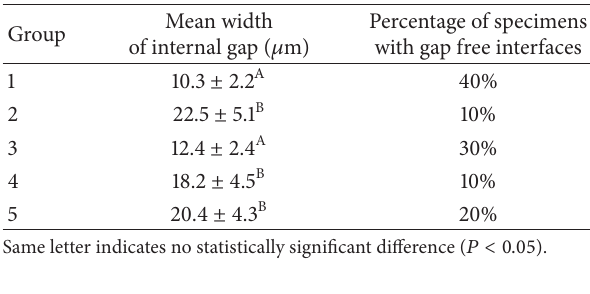
Table 3: Mean and standard deviation of internal gap ( 𝜇 m) of the experimental groups.